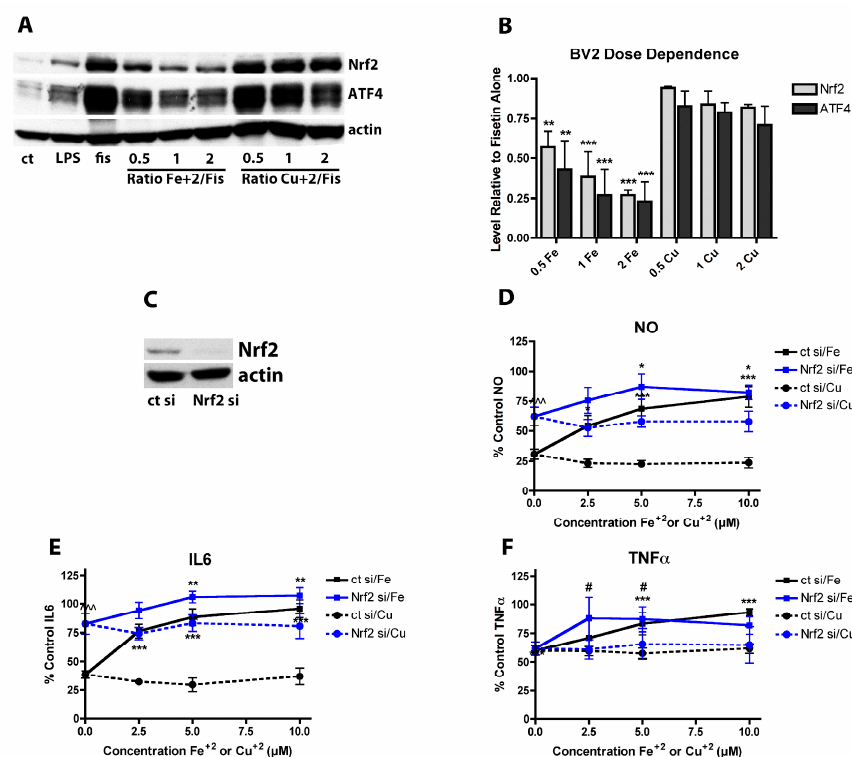
Figure 6. Nrf2 plays a key role in the anti-inflammatory e ff ects of fisetin. ( A ) Representative Western blots for Nrf2, ATF4 and actin in nuclear extracts from BV-2 cells treated with 25 ng / mL LPS alone or in the presence of 5 µ M fisetin ± the indicated concentrations of FeCl 2 or CuCl 2 for 4 h. ( B ) Quantitation of results from four independent experiments identical to ( A ). ** indicates p < 0.01 and *** indicates p < 0.001 relative to fisetin alone. ( C ) Representative Western blot of BV-2 cells treated for 48 h with control siRNA (ct si) or Nrf2 siRNA (Nrf2 si). ( D – F ) BV2 cells transfected with control siRNA (ct si) or Nrf2 siRNA (Nrf2 si) were treated overnight with 25 ng / mL LPS and 5 µ M fisetin and / or the indicated concentrations of FeCl 2 or CuCl 2 . Cell culture supernatants were cleared and assayed for NO by the Griess assay or pro-inflammatory cytokines using specific ELISAs. Results are presented as the percent (%) of the value obtained with LPS alone which was set at 100%. NO ( D ); IL6 ( E ) or TNF α ( F ). Results in ( D – F ) are the average of three independent experiments. * indicates p < 0.05, ** indicates p < 0.01 and *** indicates p < 0.001 relative to fisetin + LPS alone. # indicates p < 0.05 relative to Nrf2 siRNA with fisetin and LPS